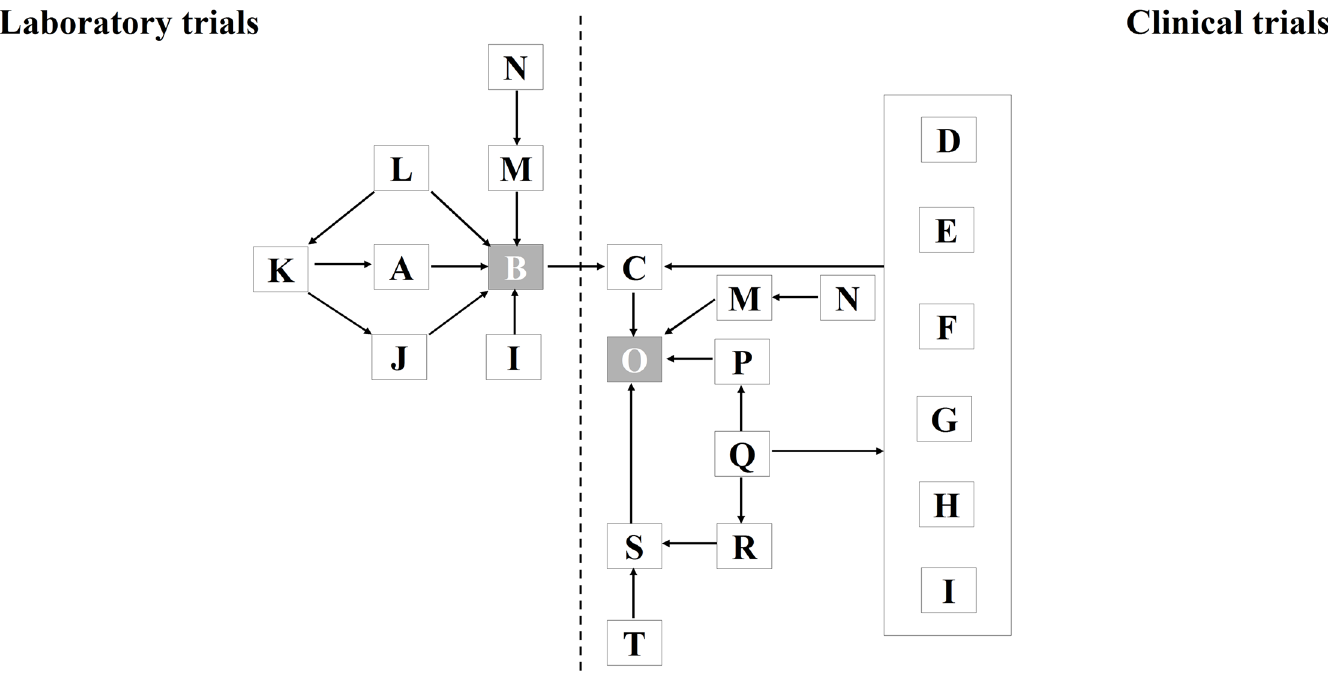
Fig 4. Directed acyclic graph (DAG). A = Material group characteristics; B = Measured laboratory outcome; C = True clinical outcome; D = Type of dentition; E = Type of tooth; F = Position of tooth in oral cavity; G = Type/Size of tooth cavity; H = Oral hygiene/habits of patient(s); I = Unknown influencing factors; J = Number of units evaluated (laboratory); K = Specimen selection process; L = Type of measurement; M = Quality /Characteristics of measurement procedure/evaluation process; N = Foreknowledge; O = Measured clinical outcome; P = Group characteristics; Q = Group selection process (randomisation); R = Number of units at baseline; S = Number of units evaluated (clinical); T = Number of units lost-to-follow-up.